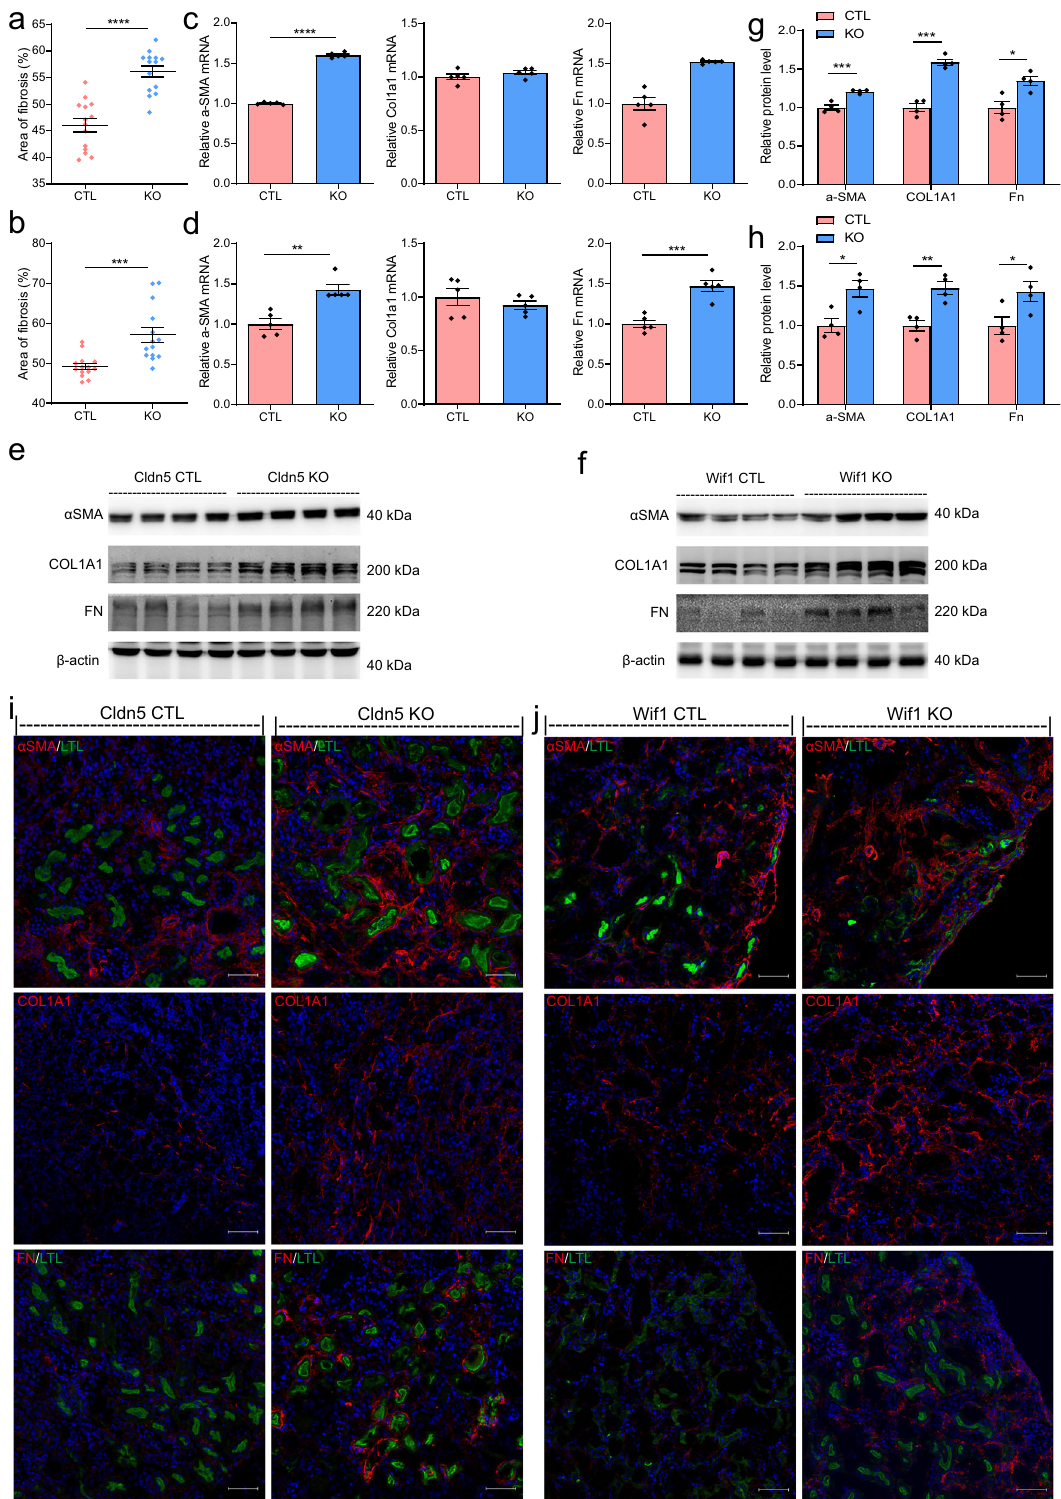
ZONAB. ZONAB localization in podocytes is affected by Cldn5 knockout along with biochemical interactions between CLDN5, ZO1, and ZONAB. And altered ZO1 distribution in Cldn5 knockout mice provides increasing evidence for functional interactions between these proteins. Loss of CLDN5 likely dis- rupts this membrane protein complex and induces the